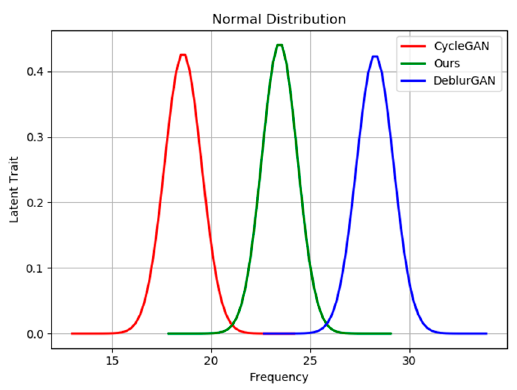
Figure 8. Perceptual test results on the GOPRO test set.